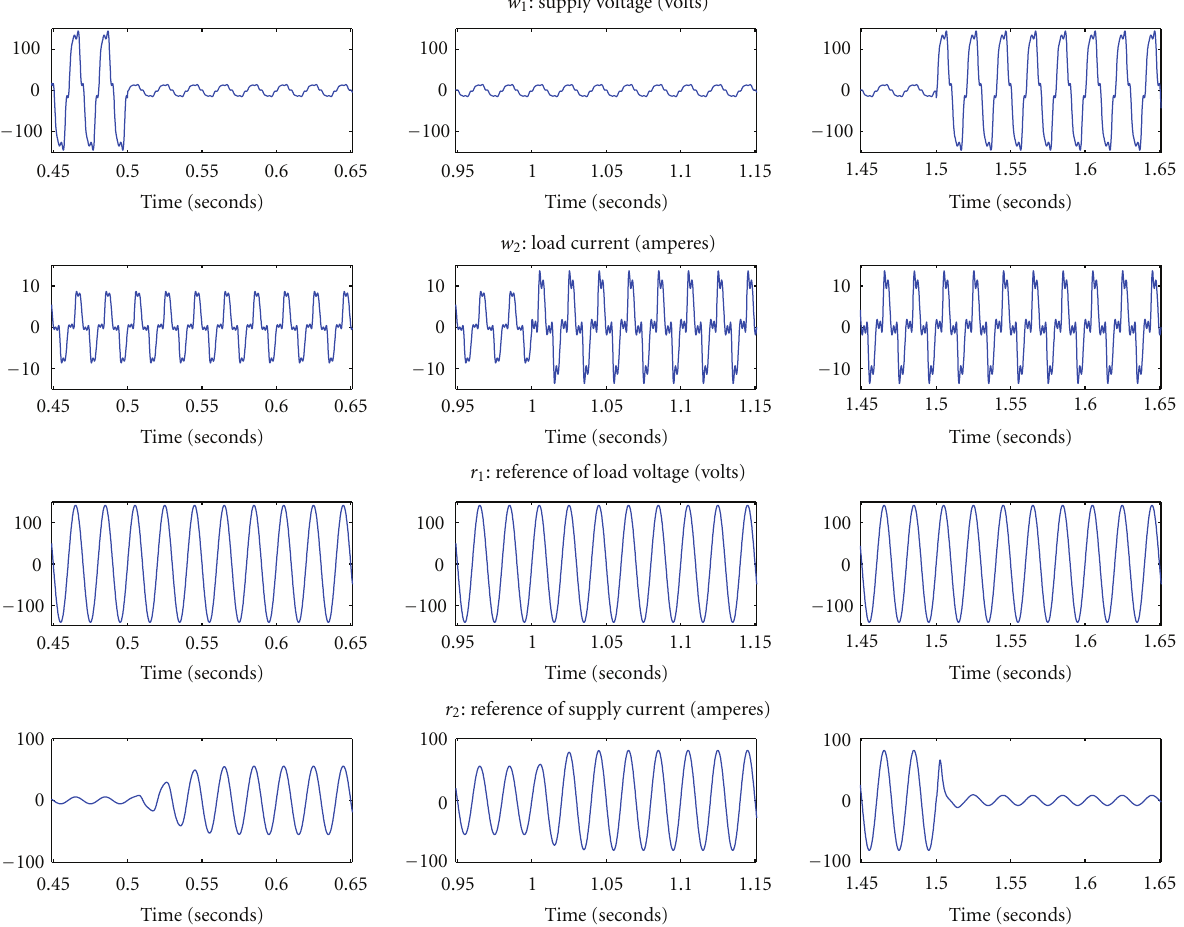
Figure 2: Simulation scenario. Voltage sag at t = 0 . 5s; load demand changed at t = 1 . 0s; sag cleared at t = 1 . 5s.